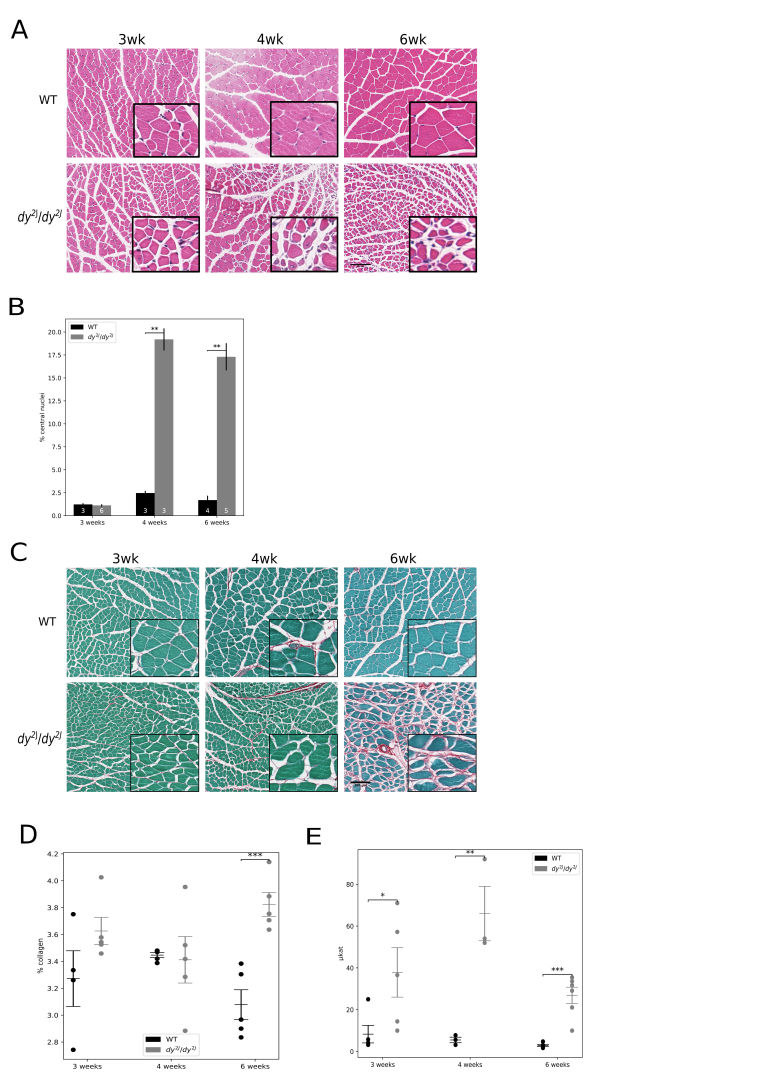
Fig. 3: Progressive muscle deterioration and collagen accumulation as
evidenced by histology and CK concentration. A: Haematoxylin and eosin staining; B:
Central nucleation quantification (as percentage of fibres with central nuclei); C:
Fast green/sirius red staining: collagen is coloured red; D: Quantification of
collagen as percentage of total protein; E: CK. Scale bars = 100 μm; * p < 0.05, **
p < 0.01, *** p < 0.001. Source: Fig. 3C originally published in: Moreira Soares
Oliveira B, Durbeej M, Holmberg J (2017) Absence of microRNA-21 does not reduce
muscular dystrophy in mouse models of LAMA2-CMD. PLoS ONE 12(8): e0181950.
https://doi.org/10.1371/journal.pone.0181950.